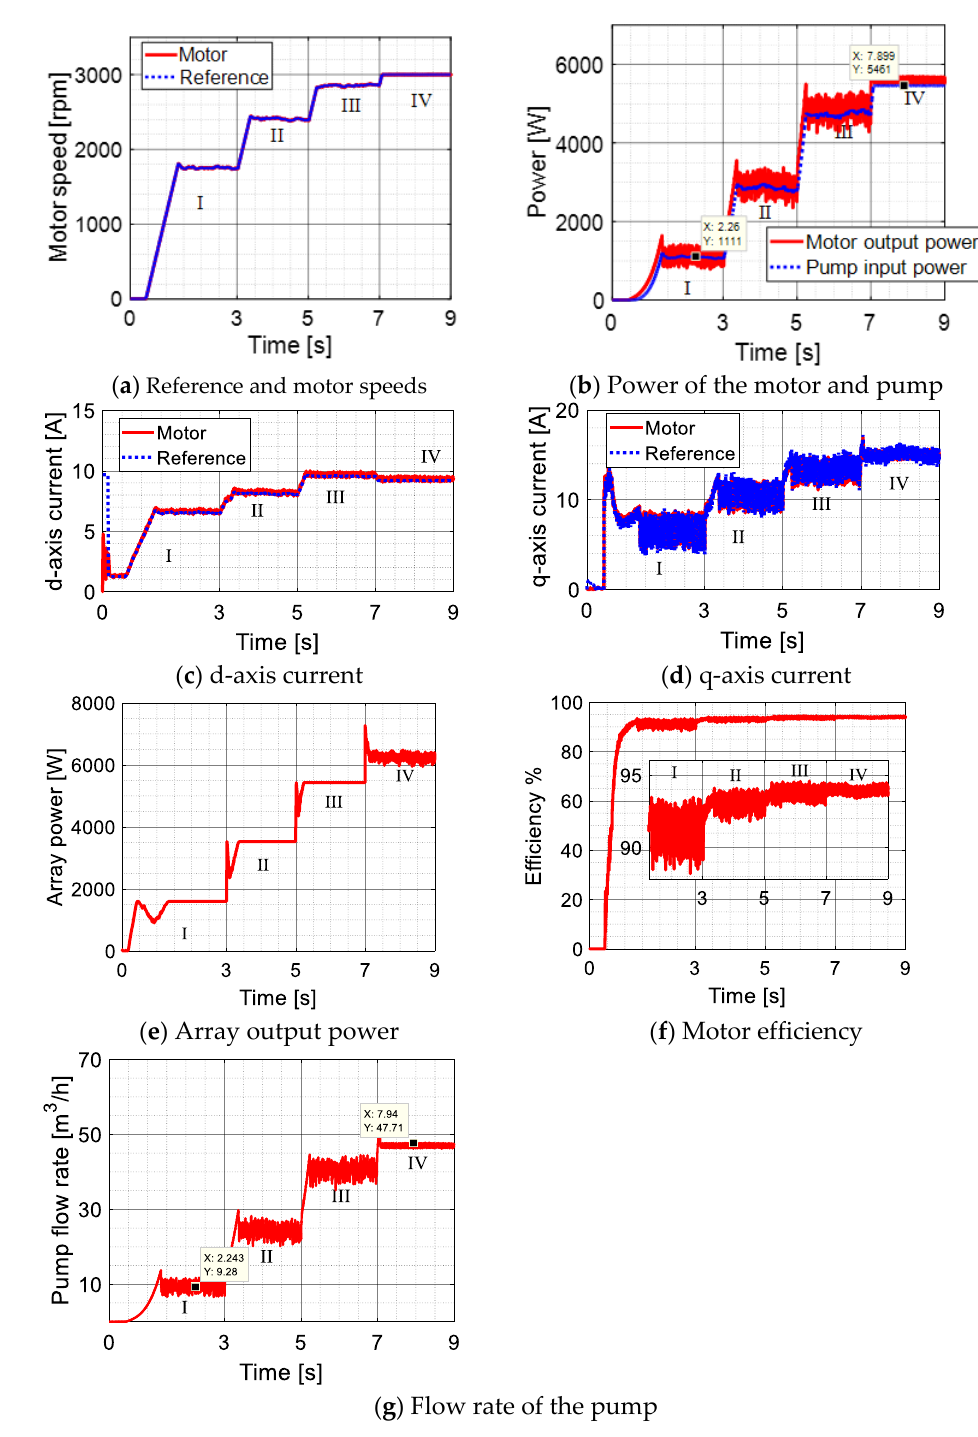
Figure 11. Performance of the system based on SynRM at ambient temperature of 30 °C and various solar irradiation levels (I = 0.25 kW/m 2 , II = 0.5 kW/m 2 , III = 0.75 kW/m 2 and IV = 1 kW/m 2 ).